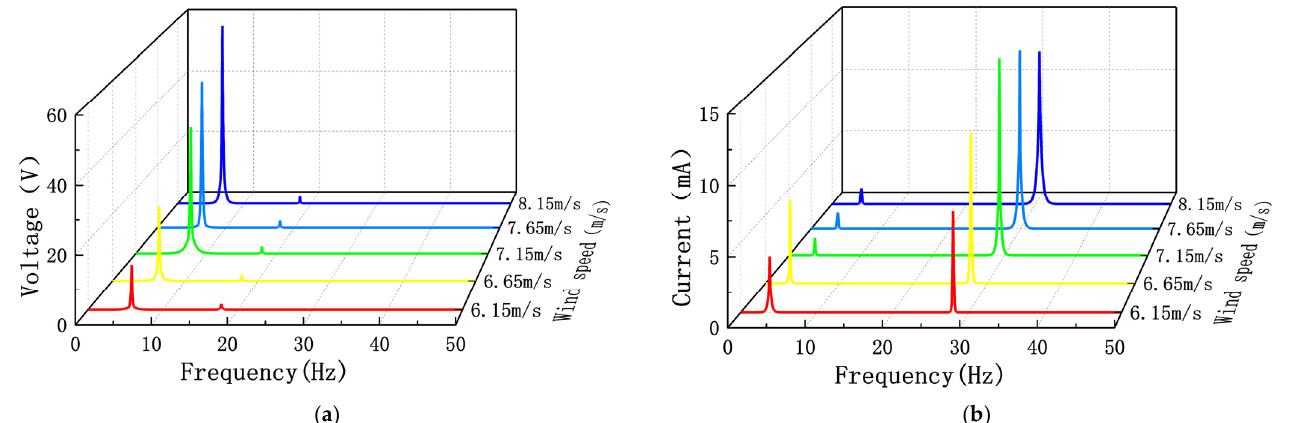
Figure 10. Fourier transform curve under different wind speeds before and after the jump at d 0 is 34 mm ( a ) the PEH ( b ) the EEH.